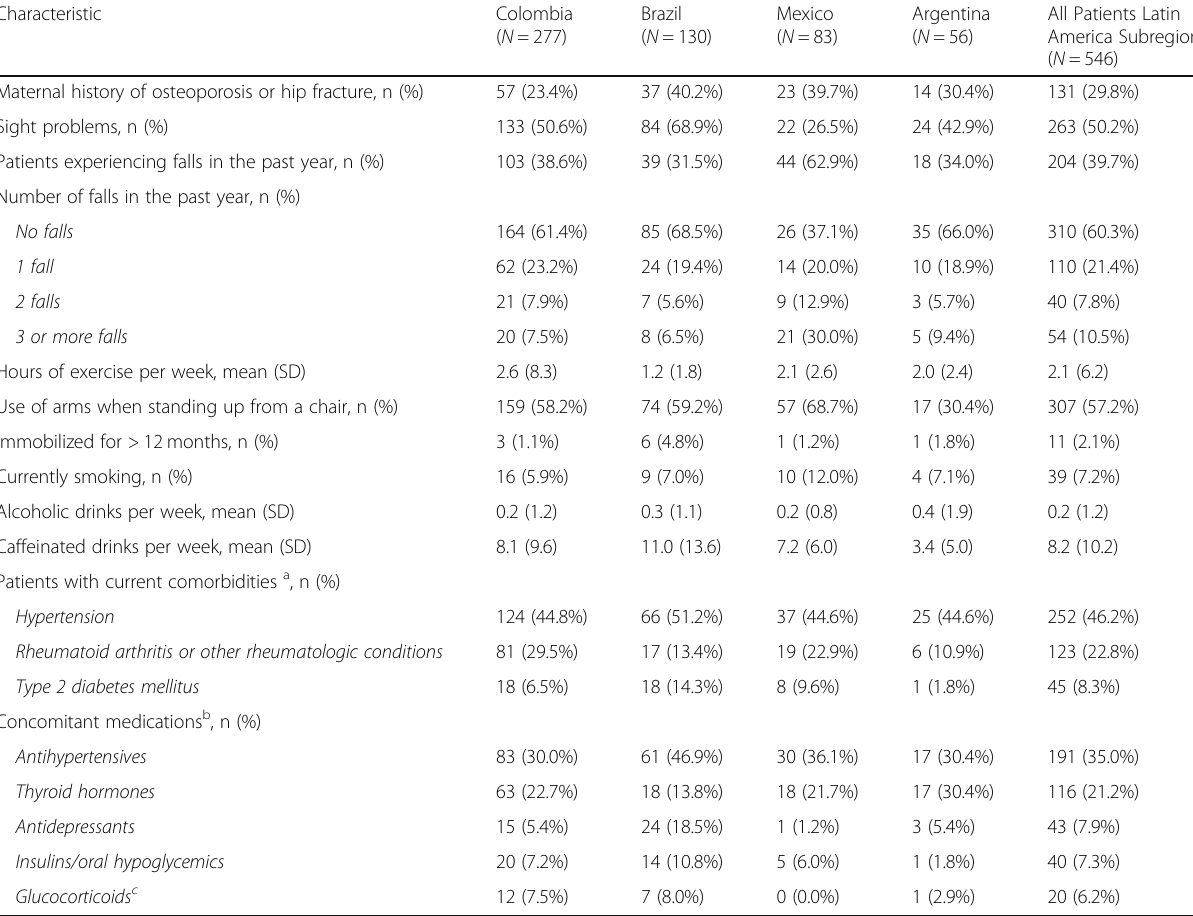
Table 2 Risk factors for osteoporosis and fractures, current comorbidities, and concomitant medications Characteristic Colombia ( N =